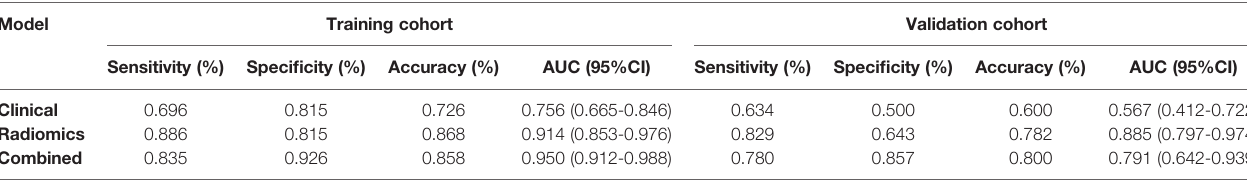
TABLE 3 | Performances of models for PNI prediction. Model